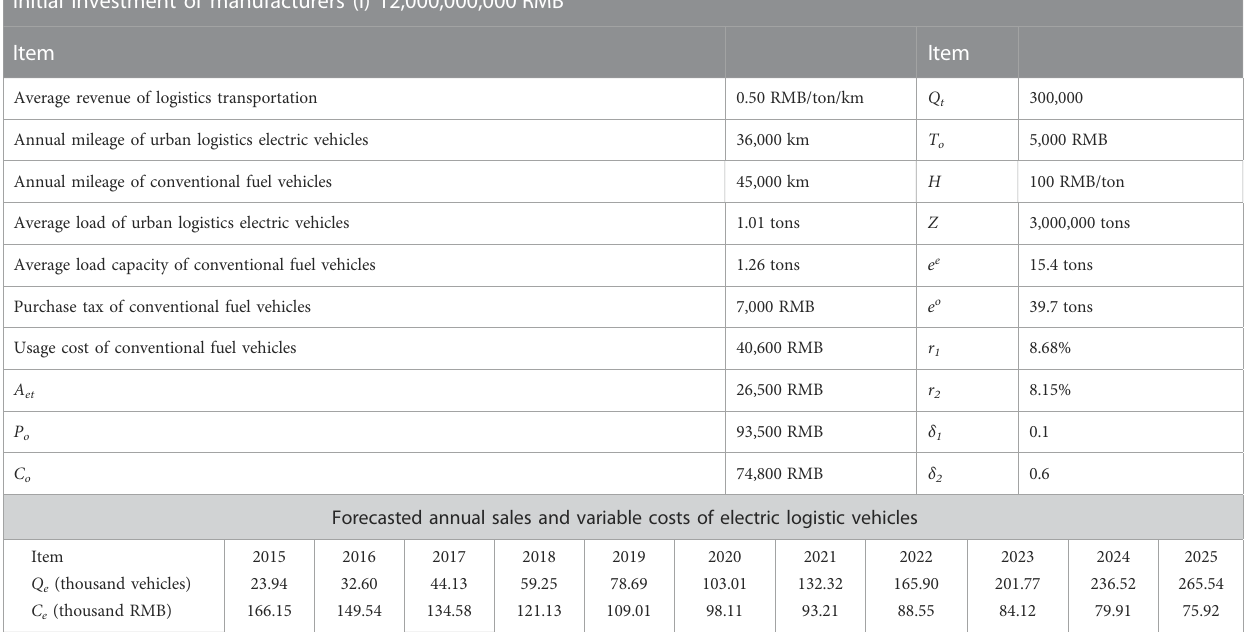
TABLE 3 Data collection and